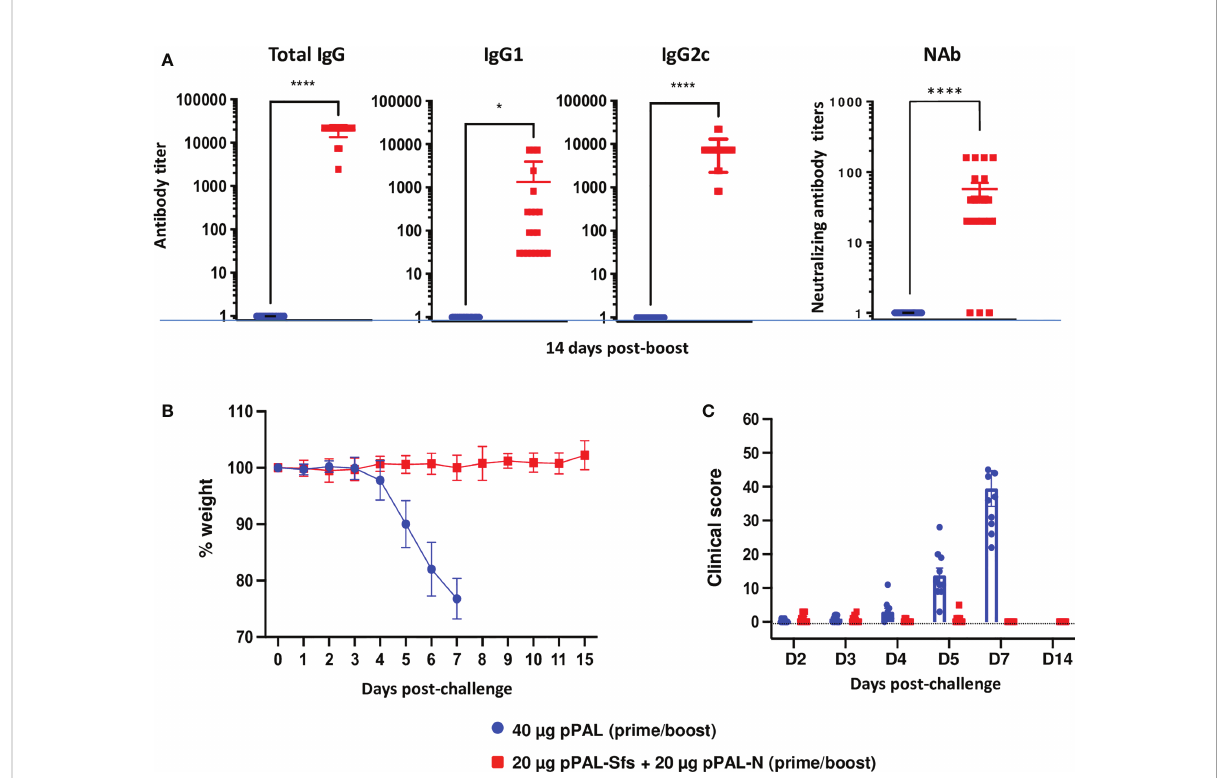
FIGURE 8 The pPAL-Sfs + pPAL-N vaccine confers full protection against challenge with 10 5 PFU of the SARS-CoV-2 Delta variant in the K18-hACE2 murine model. (A) Titration of circulating anti-RBD IgG, IgG2c, and neutralizing antibodies 15 days after prime/boost immunization with pPAL- Sfs + pPAL-N. (B) Body weight evolution after 10 5 PFU SARS-CoV-2 challenge. Vaccinated animals maintained their weight throughout the experiment, whereas weight decreased in the control group. (C) Clinical sign follow-up after challenge with 10 5 PFU SARS-CoV-2.